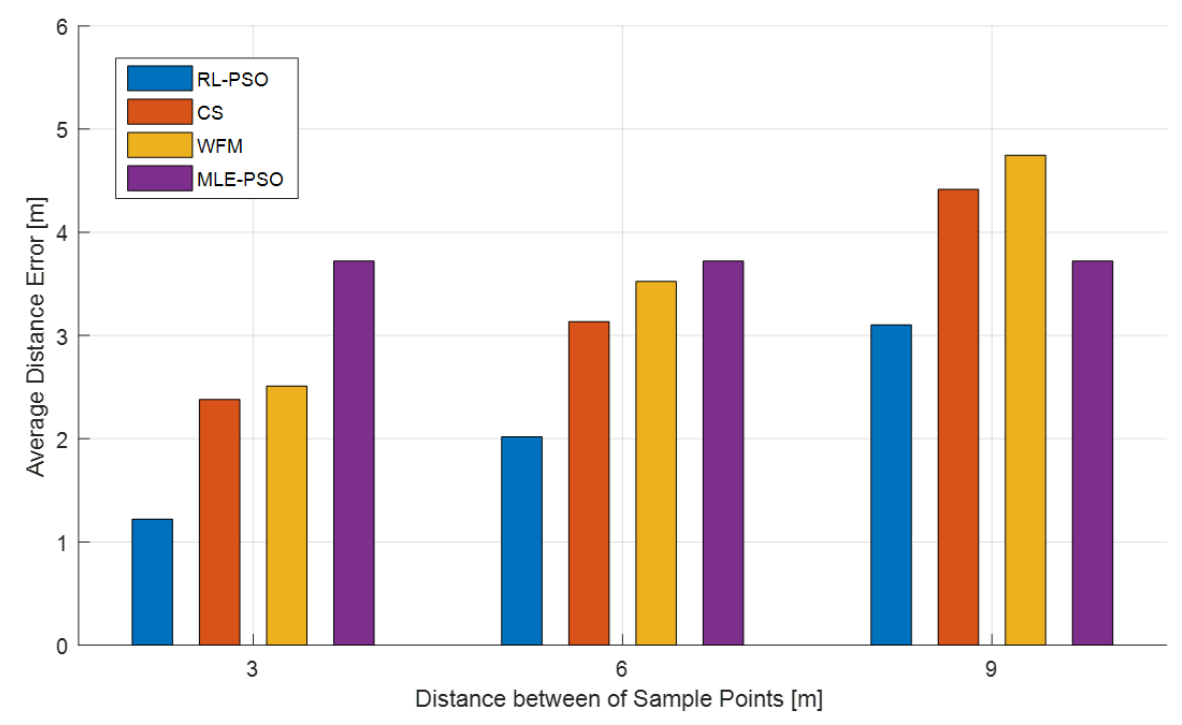
Figure 8. Positioning error according to distance between SPs.